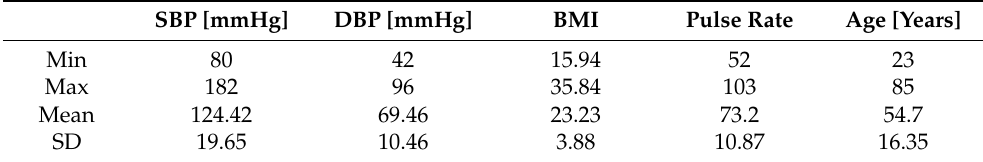
Table 7. Statistical information of the selected